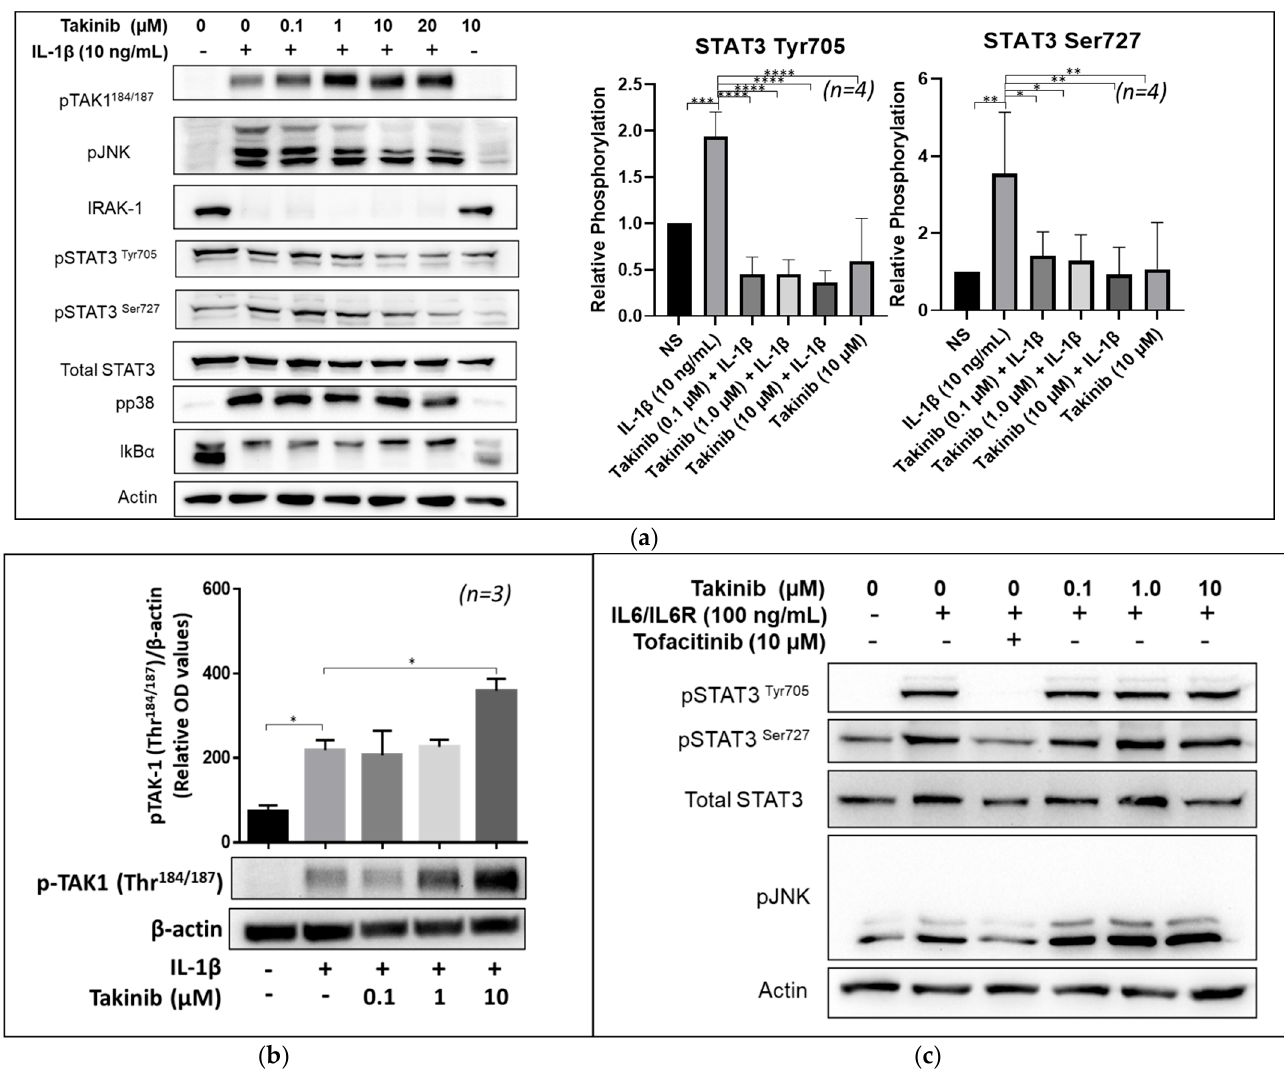
Figure 2. Treatment of RASFs with takinib and either IL-1 β or IL-6 trans-signaling demonstrates differential activation of signaling pathways. ( a ) RASFs were pre-treated for two hours with takinib followed by 30 min stimulation with IL-1 β (10 ng/mL). Whole cell extracts were collected and analyzed by Western Blot. Takinib induces phosphorylation of TAK1 while reducing STAT3 phosphorylation at the Tyr705 and Ser727 residues in n = 4 RASF cell lines. ( b ) Takinib demonstrates increasing phosphorylation of the Thr184/187 residues in the kinase loop of TAK1. ( c ) RASFs were pre-treated with takinib followed by 30 min stimulation with IL-6 and IL-6R (100 ng/mL). Whole cell extracts analyzed by Western Blot show no effect on STAT3 phosphorylation by Takinib in n = 3 RASF lines. * = p < 0.05, ** = p < 0.001, *** = p < 0.0001, **** = p < 0.00001.